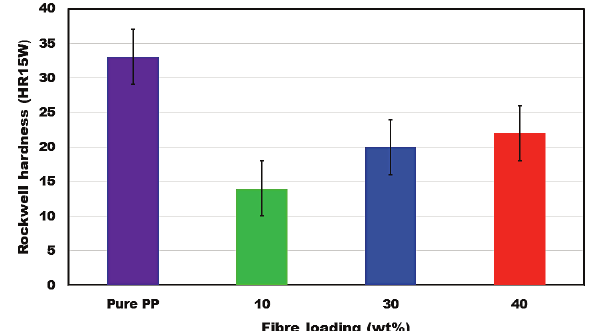
Table 2. PP/CF hybrid composite tribology response